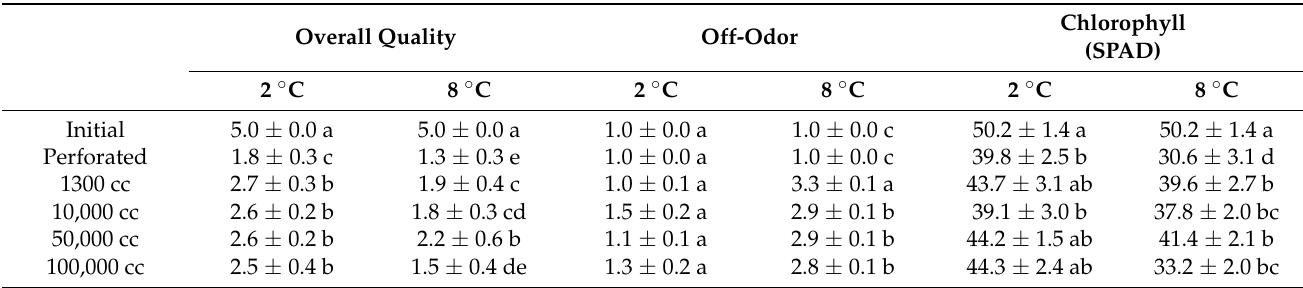
Table 3. The overall quality, off-odor, and chlorophyll contents of fresh-cut romaine lettuce in OTR film in MA storage at and 8 ◦ C for 15